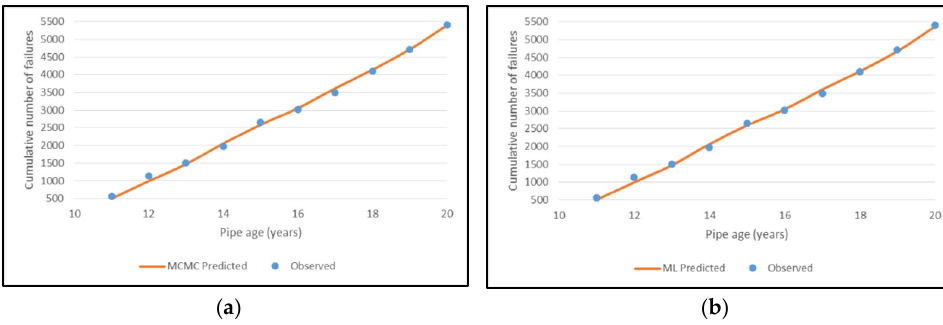
Figure 8. Cumulative plot of pipe failures. ( a ) MCMC estimation; ( b ) ML estimation.